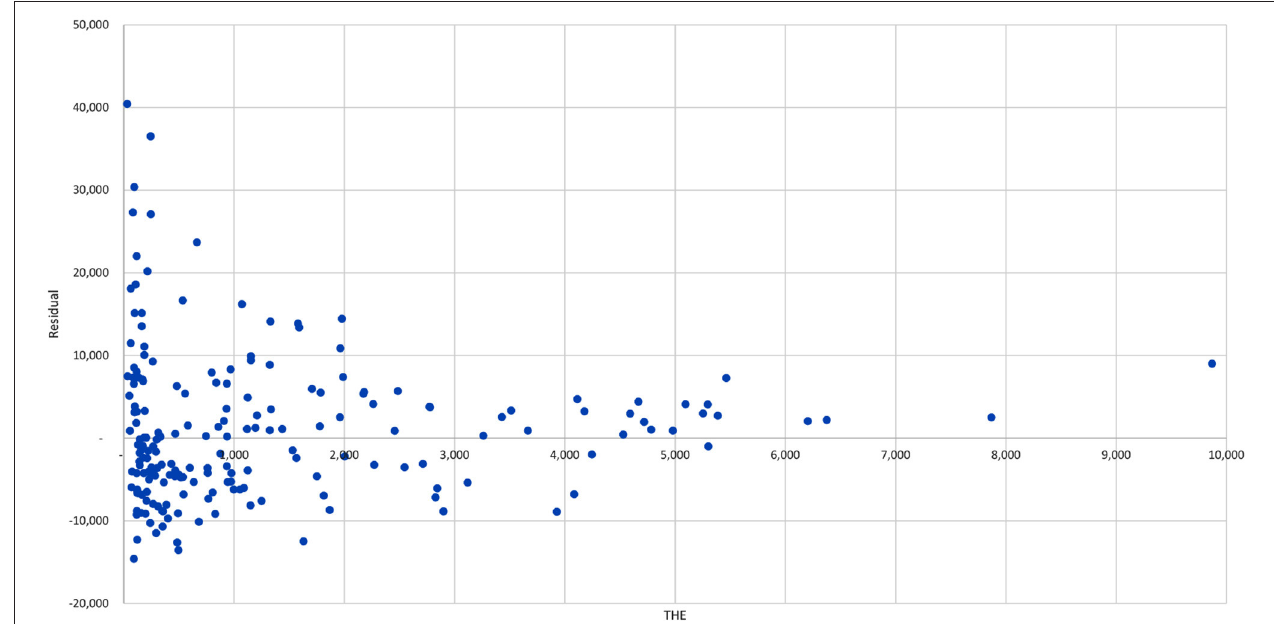
FIGURE 3 | Residual vs. THE for 2016.